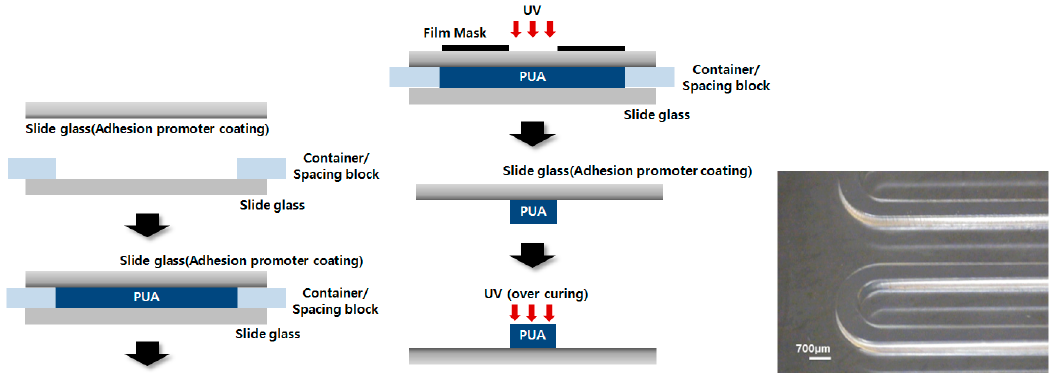
Figure 3. The resulting microchannel was 700 μ m in width and 118 mm in length.